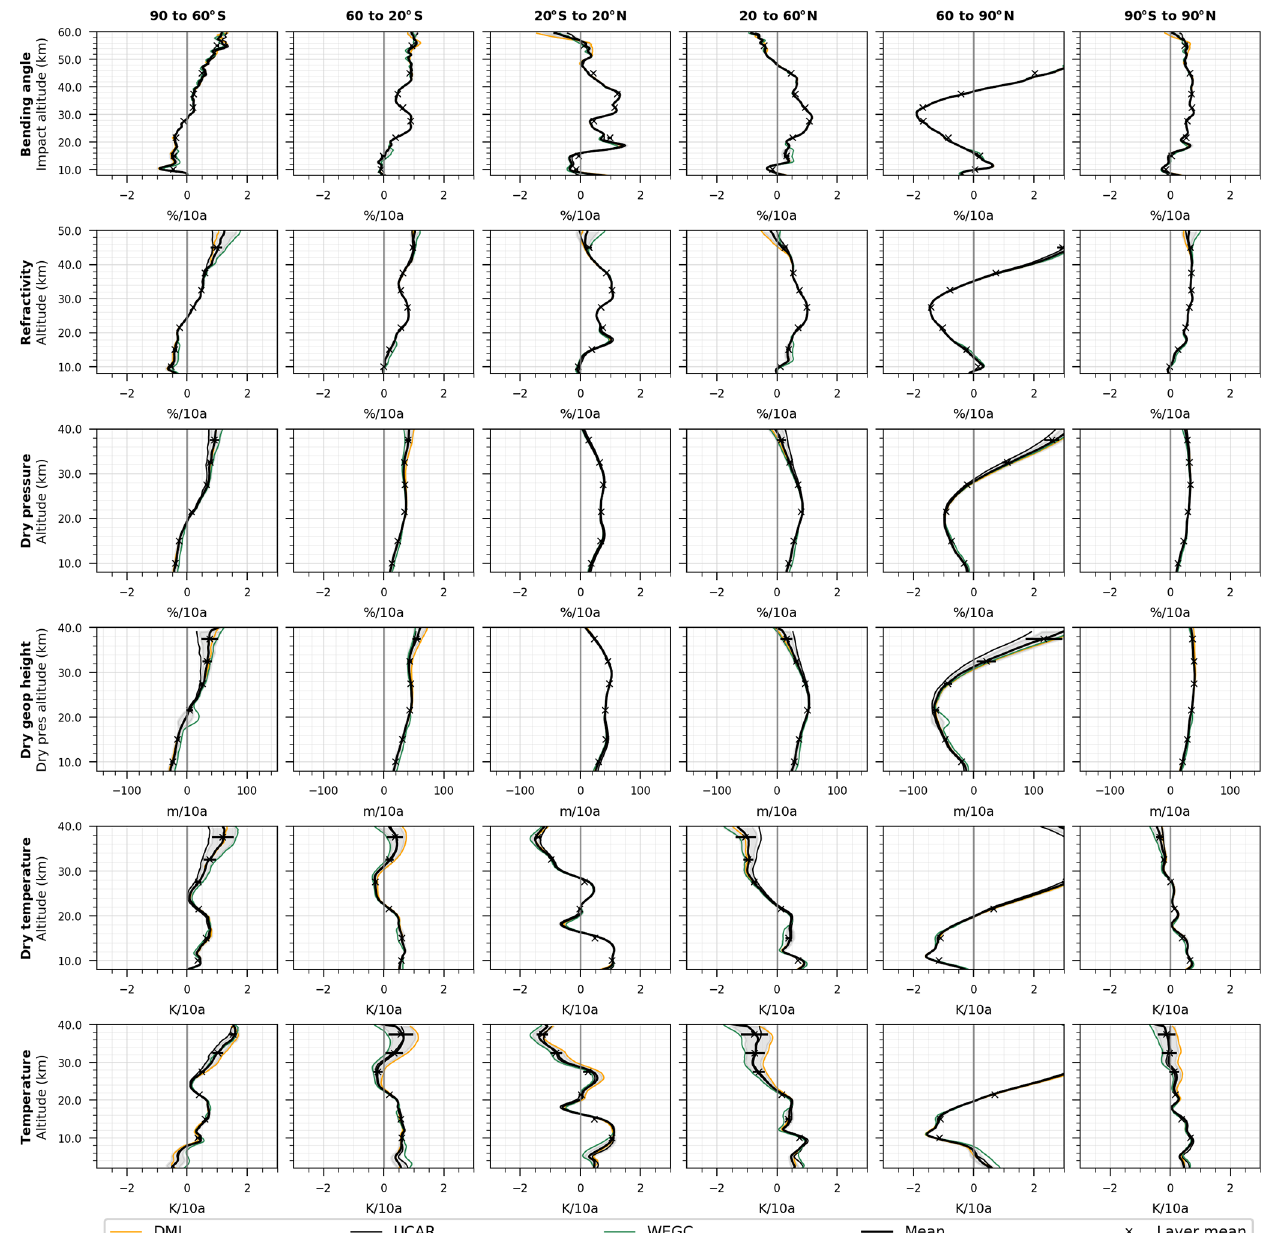
Figure 11. Metop structural uncertainty indicated as the standard deviation (gray) of the individual center trends per decade based on 10 ◦ zonal medians for DMI (orange), UCAR (black), and WEGC (green); shown for bending angle, refractivity, dry pressure, dry geopotential height, dry temperature, and temperature (top to bottom). The all-center mean trend profile (bold black line) and the altitude-layer mean trends (crosses, with horizontal bars showing the uncertainty) are indicated. Profiles are smoothed with a 1km running